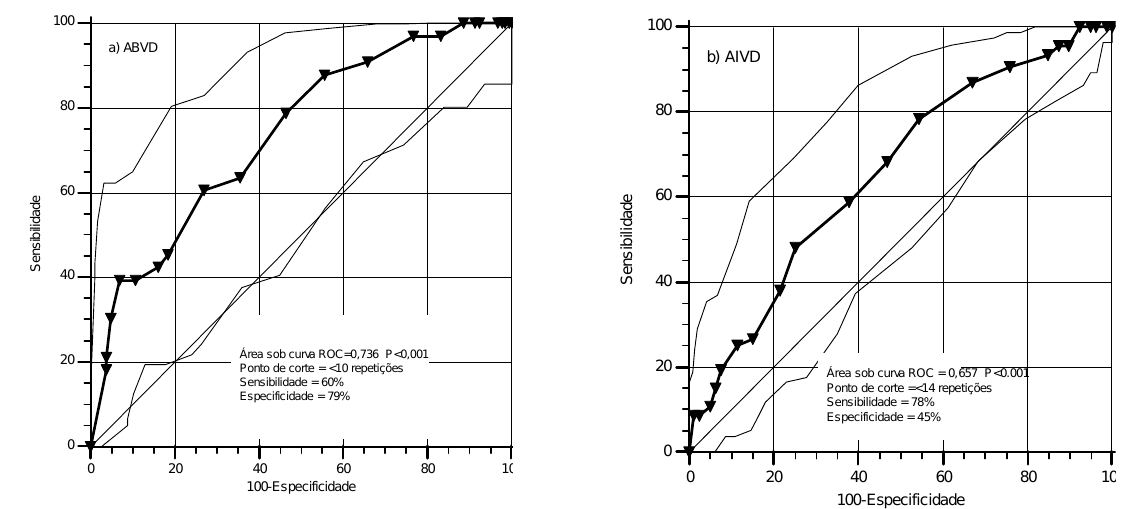
Figura 1. Área sob a curva ROC com o ponto de corte para o número de repetições no teste de sentar e levantar da cadeira como preditor para incapacidade funcional em homens idosos.